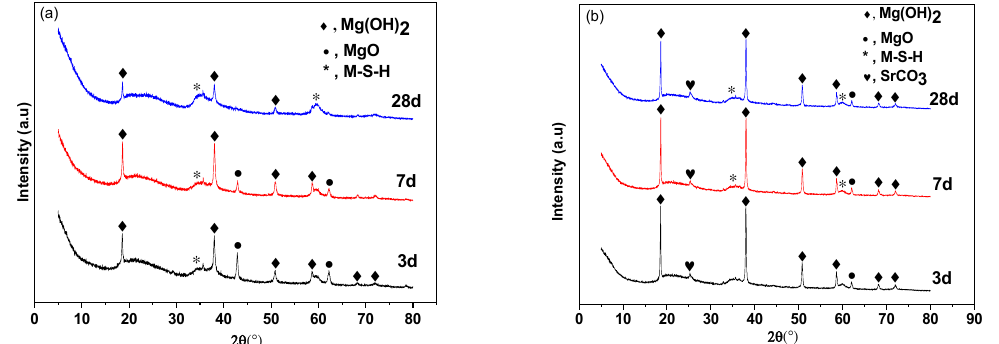
Figure 2. X-ray diffraction spectra of different curing periods of the MgO–SiO 2 –H 2 O solidified bodies with or without added strontium. ( a ) No added strontium; ( b ) with 3.2 wt.% added strontium.